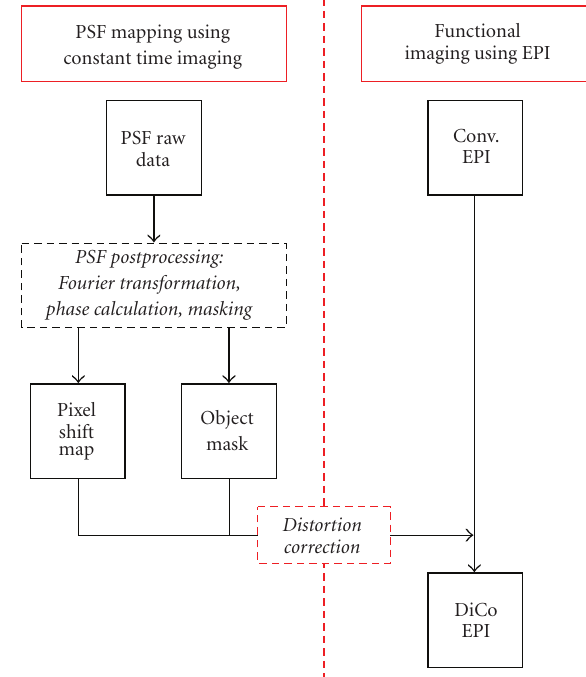
Figure 2: PSF data acquisition and postprocessing chain for EPI distortion correction. PSF data are acquired and a Pixel Shift Map (PSM) calculated. The PSM is later applied on conventional EPI inside the image mask in order to improve image quality (right side of flow